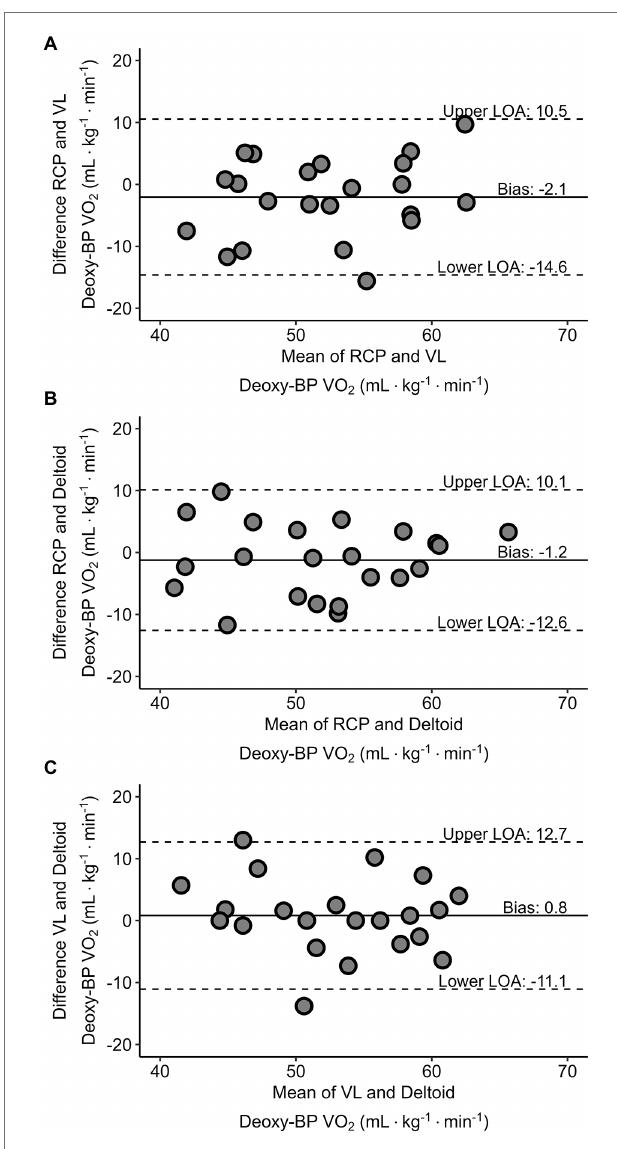
FIGURE 5 | Bland–Altman plots displaying agreement between V ̇ O 2 (ml·kg − 1 ·min − 1 ) corresponding with RCP and VL Deoxy-BP (panel A ), RCP and deltoid Deoxy-BP (panel B ), and VL and deltoid Deoxy-BP (panel C ). The horizontal solid line represents the mean difference between each of the two measurements. The paired horizontal dotted lines represent the 95% limits of agreement for each of the